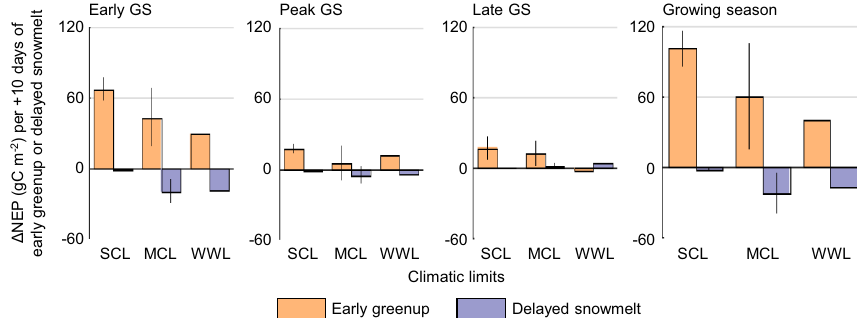
Fig. 5 Net ecosystem productivity (NEP) changes due to early greenup and delayed snowmelt under each climatic limit. The NEP change ( Δ NEP) per 10 days of early greenup or delayed snowmelt with each climatic limit (strongly temperature and water-colimited, SCL; moderately colimited, MCL; weakly water-limited, WWL). The mean value of the sites with the same limit is represented as a bar, with one standard deviation indicated by the vertical line (there is only one weakly water-limited site, therefore no standard deviation